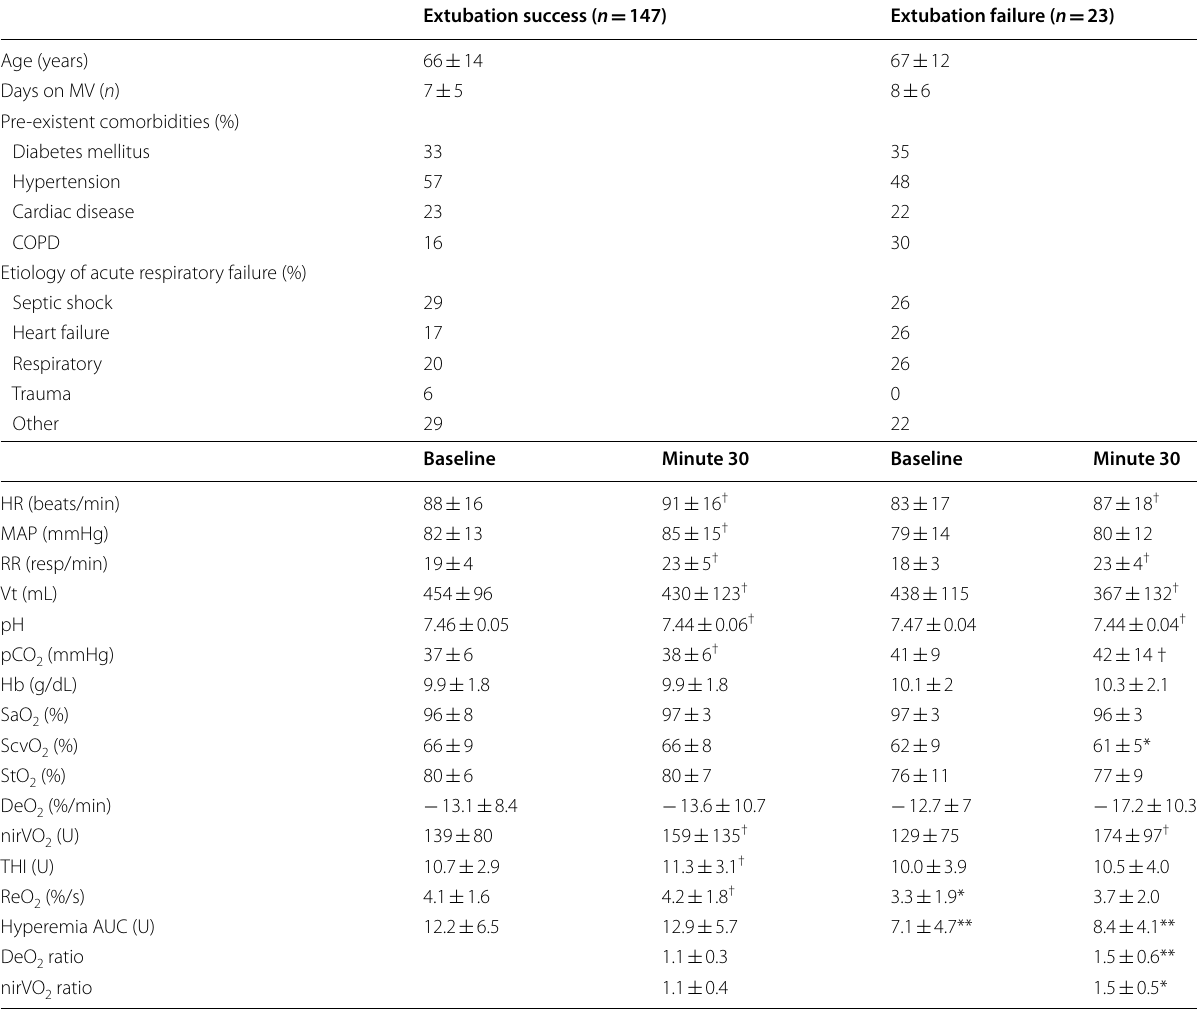
Table 1 Characteristics of the patients who succeed the spontaneous breathing trial